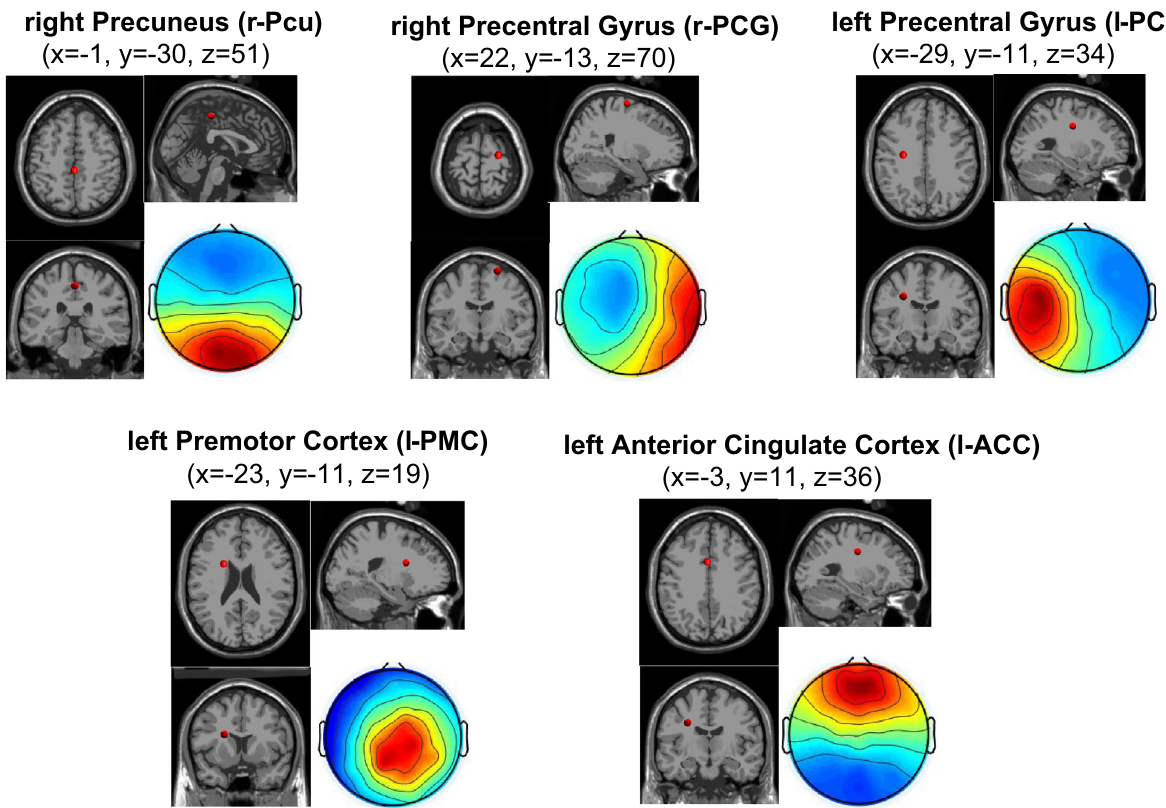
Figure 1. Results of K-means clustering of brain ICs across subjects. The scalp map related to each centroid is obtained as the average of single-subject scalp maps assigned to the cluster. Associated equivalent current dipoles are depicted in red within a standard MRI template and labeled according to the nearest portion of gray